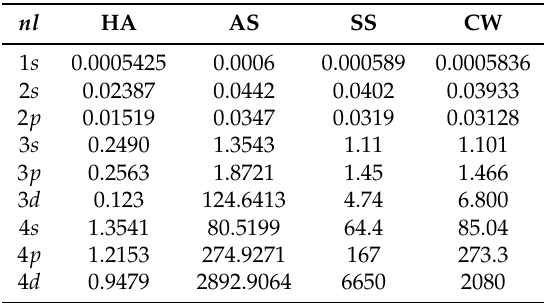
(cid:10) (cid:11) r 3 Table 5. Values of calculated by the Hydrogenic approximation (HA) and by the AS, SS, and CW atomic structure codes in